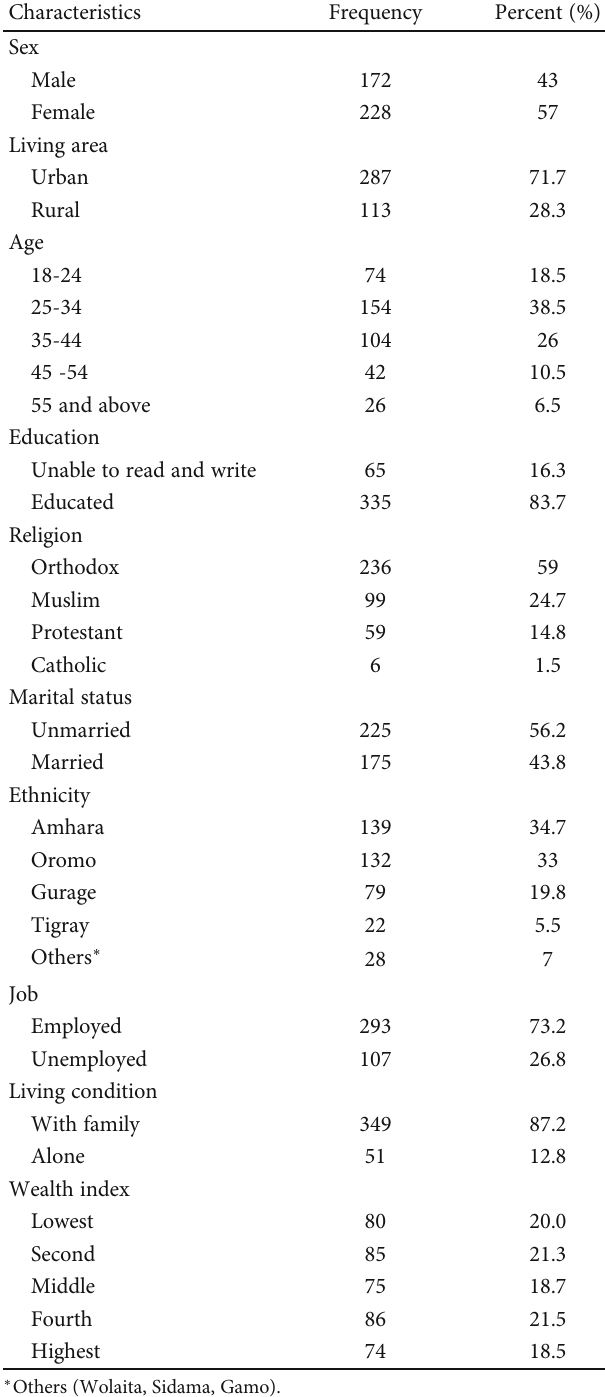
Table 1: Sociodemographic factors of the participants at the Amanuel Mental Specialized Hospital ( n = 400 ),